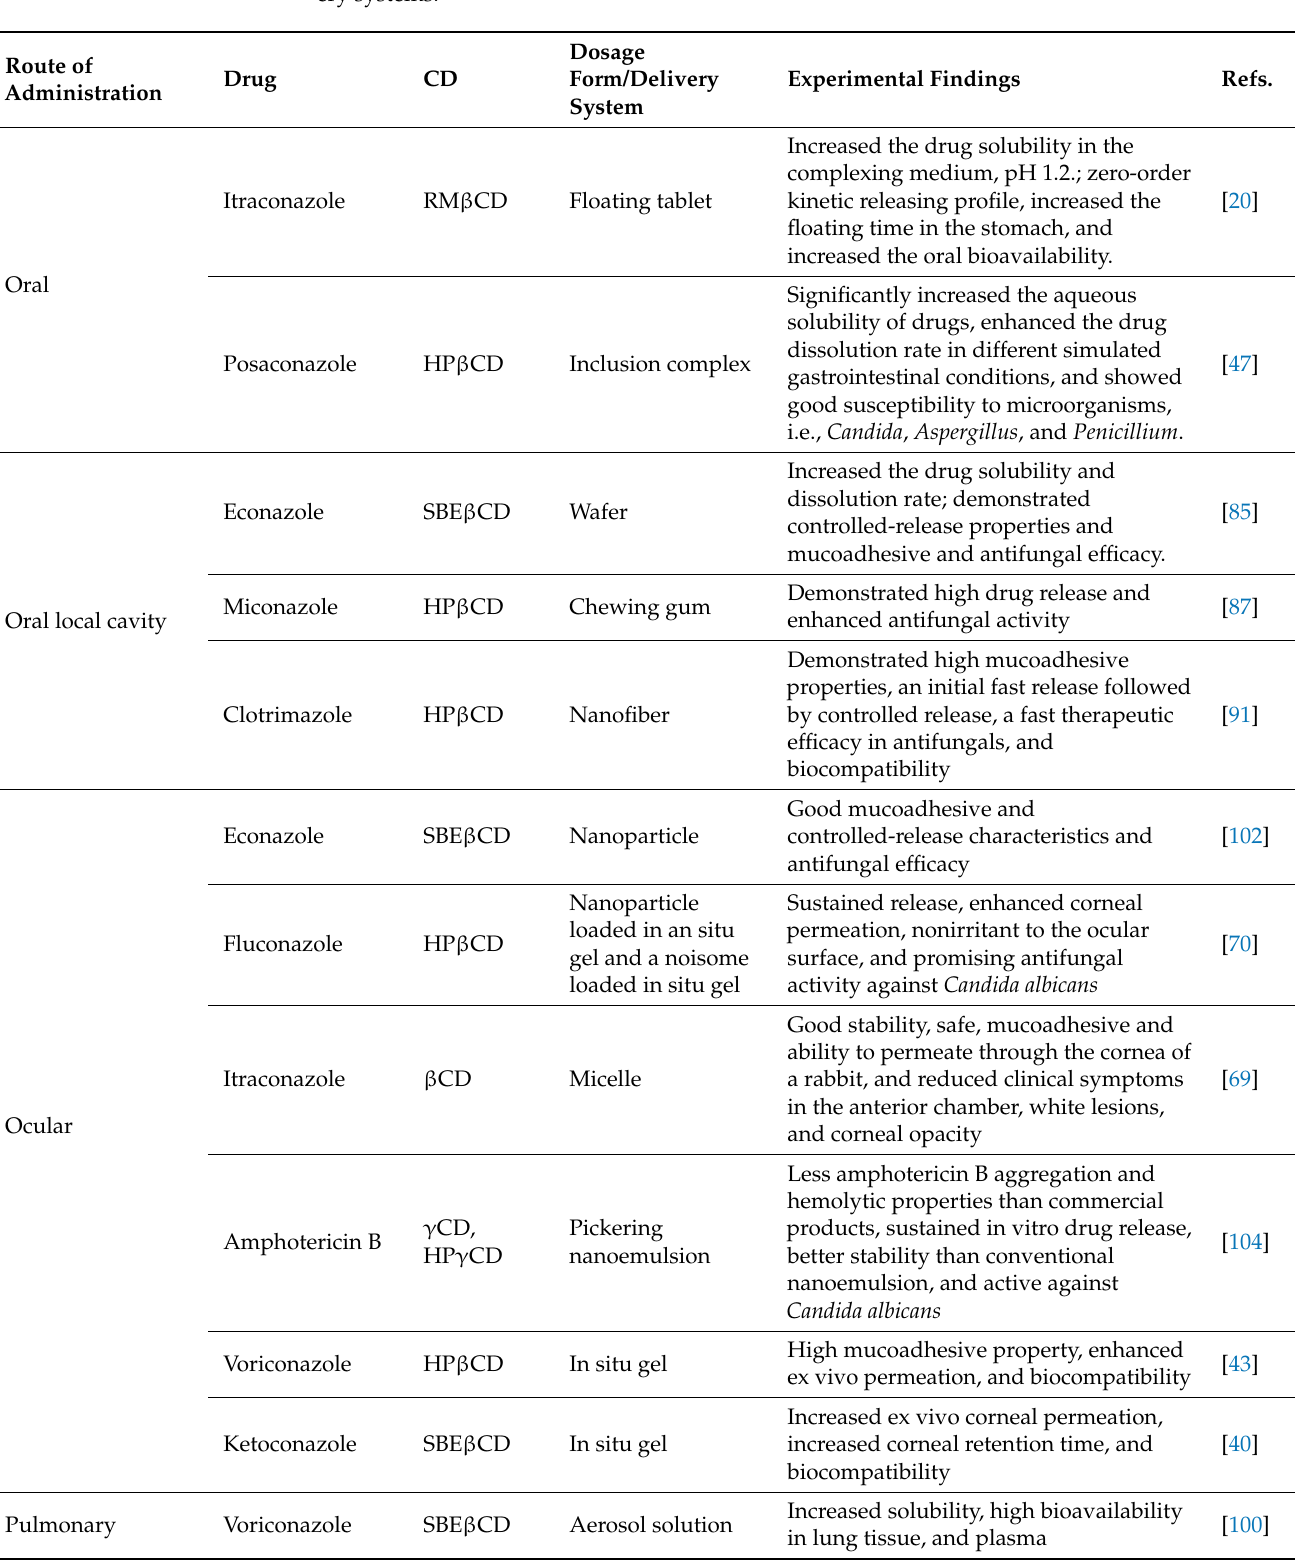
Table 4. Examples of CD-based formulations containing antifungal agents for various drug deliv- ery